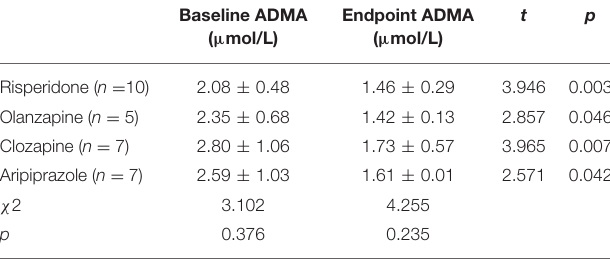
TABLE 3 | Plasma ADMA levels before and after